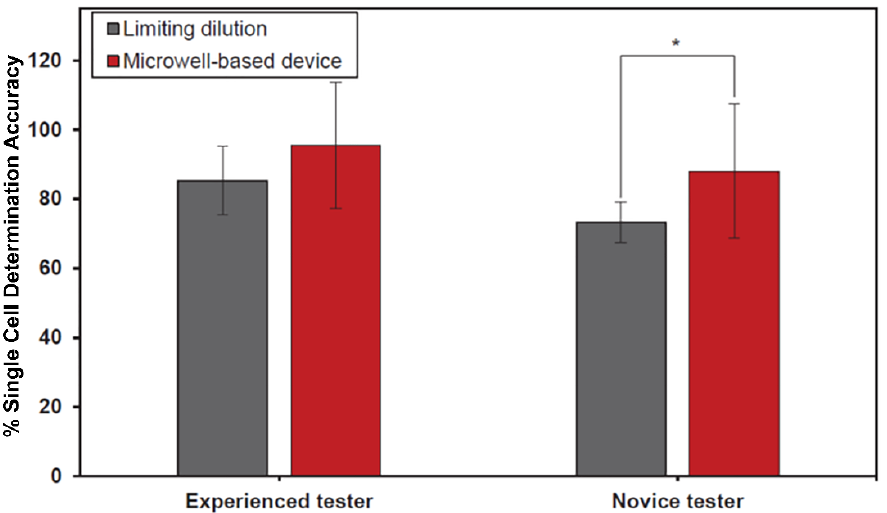
Figure 6. Comparison of the percentage of single-cell trapping correctness using limiting dilution and the MBM device. The results obtained from the experienced group ( n = 5) and the novice group ( n = 5) were reported as mean ± standard deviation. The asterisk between columns indicates a significant difference at p < 0.05 using a paired t -test. Each pair of columns was analyzed